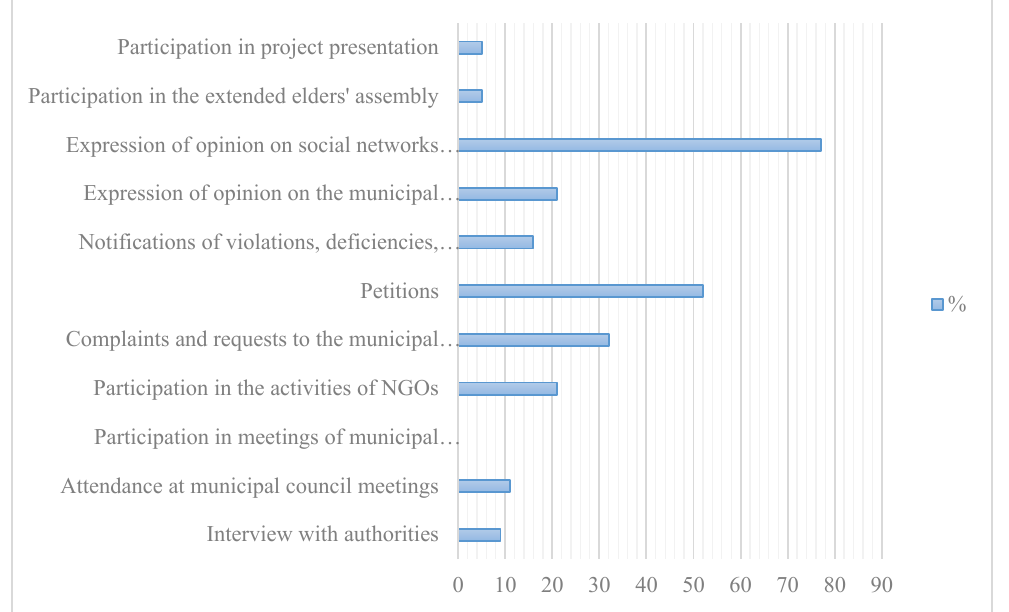
Figure 4. Communication techniques with the municipality used over the last 12